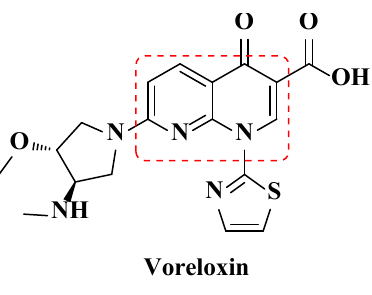
Figure 1: The chemical structure of